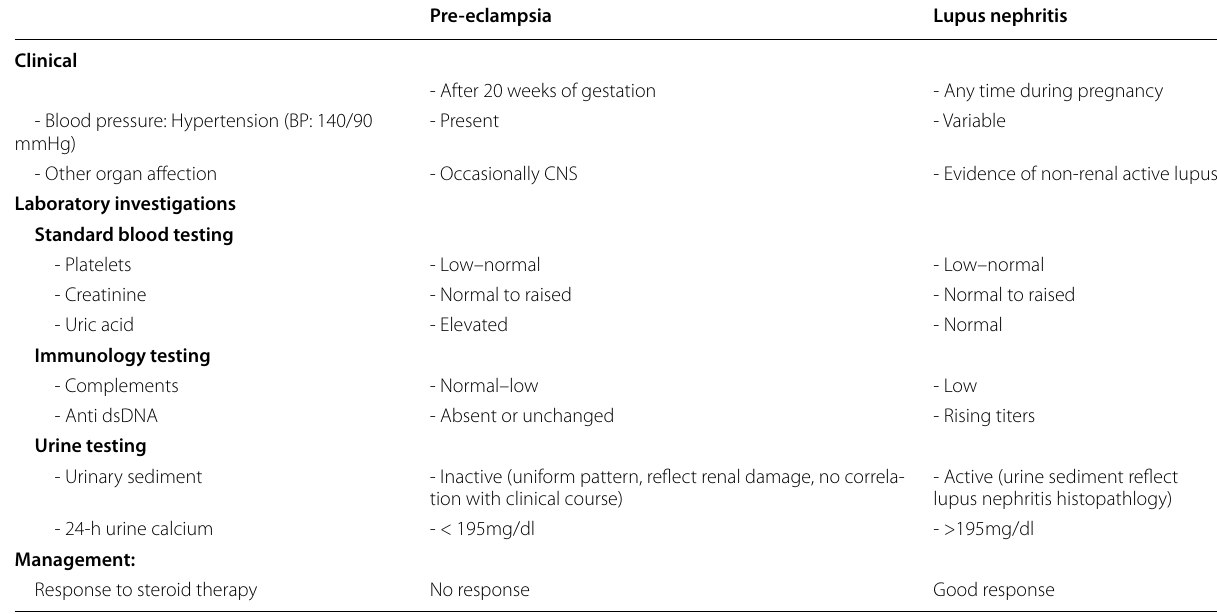
BP blood pressure, dsDNA double-strand DNA, CNS central nervous